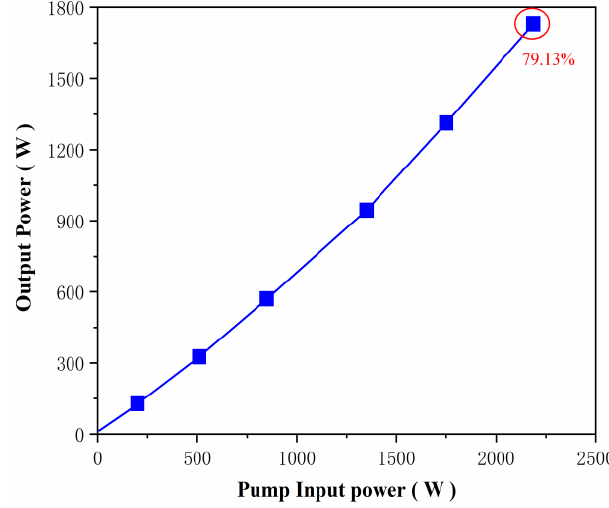
Figure 5. Optical-to-optical conversion efficiency.